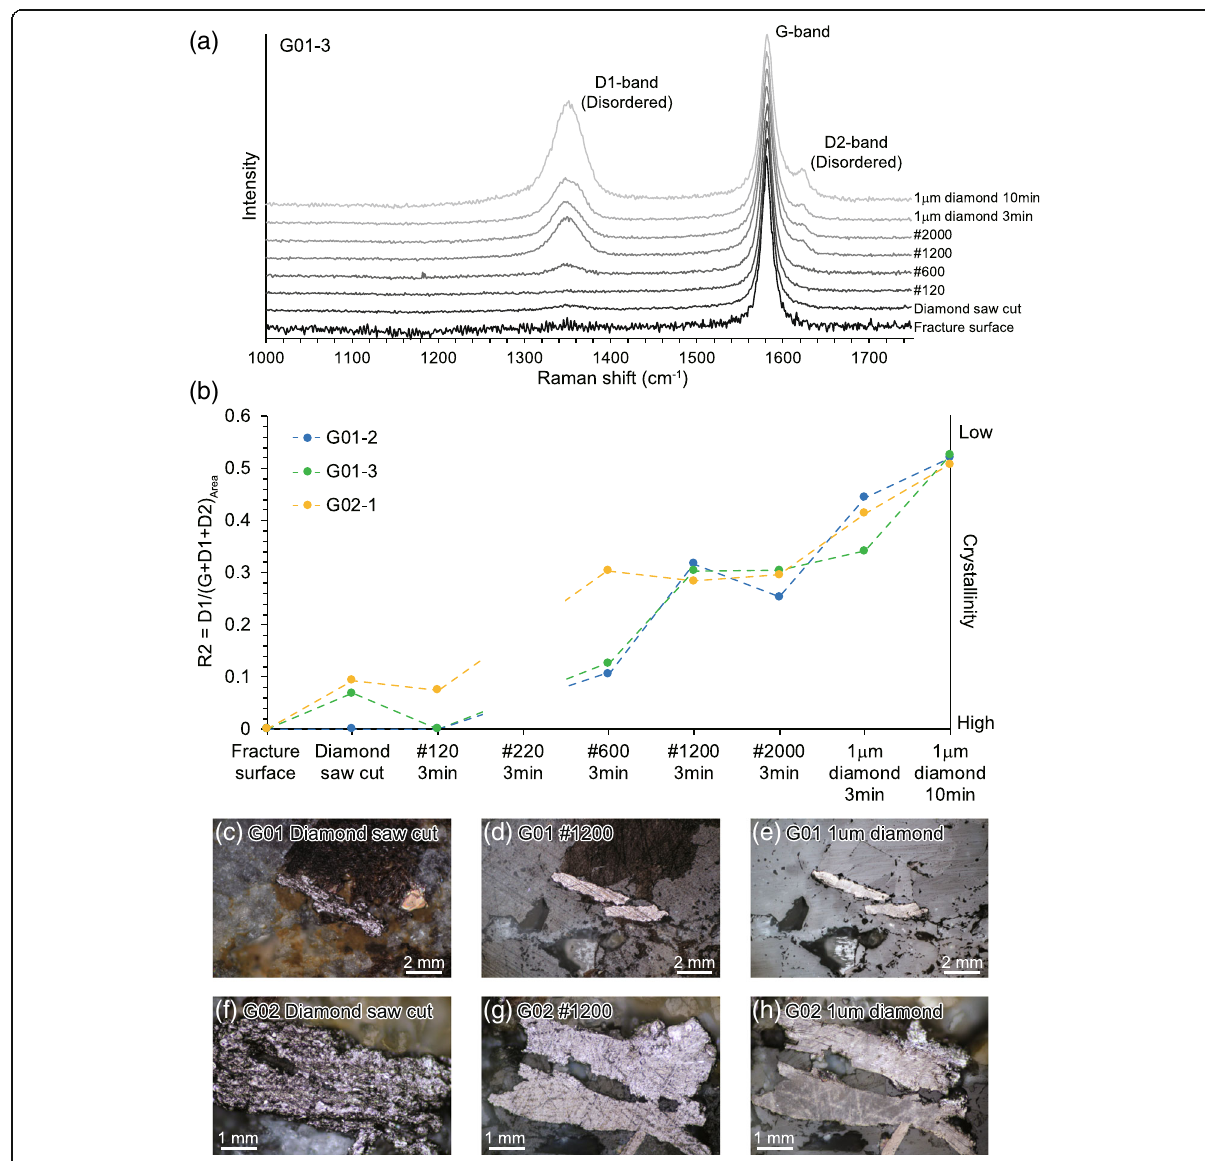
Fig. 3 Change of Raman spectra and its crystallinity parameter (R2) at each sample preparation step from diamond-tipped saw cutting to 1 μ m diamond paste on three spots (G01-2, G01-3, G02-1). a Change of Raman spectra at each sample preparation step at the spot of G01-3. b Change of crystallinity parameter (R2) at each step except #220. Raman measurement after #220 was skipped, and its R2 data are blank. c – h Surface shape change under reflected microscope after cutting by a diamond-tipped saw ( c , f ), after 3min by #1200 polishing ( d , g ), and after 10min by diamond paste polishing ( e , h ) of grains G01 and G02. Please note that the rough polishing steps scrap the surface greatly and not always measure exactly the same point as in previous polishing